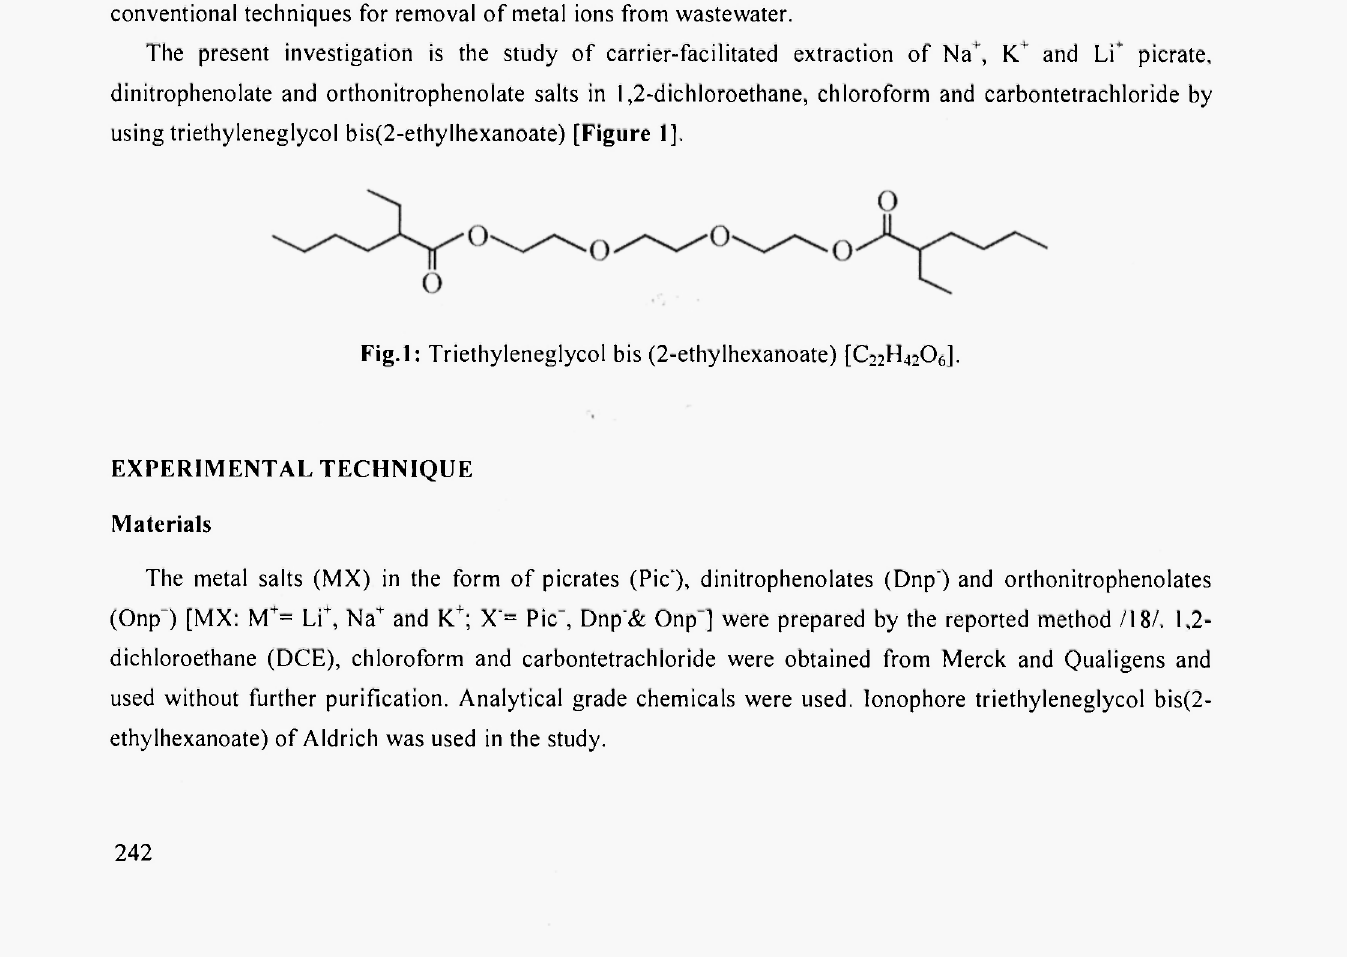
Fig.l: Triethyleneglycol bis (2-ethylhexanoate) [C 2 2H.,20 6